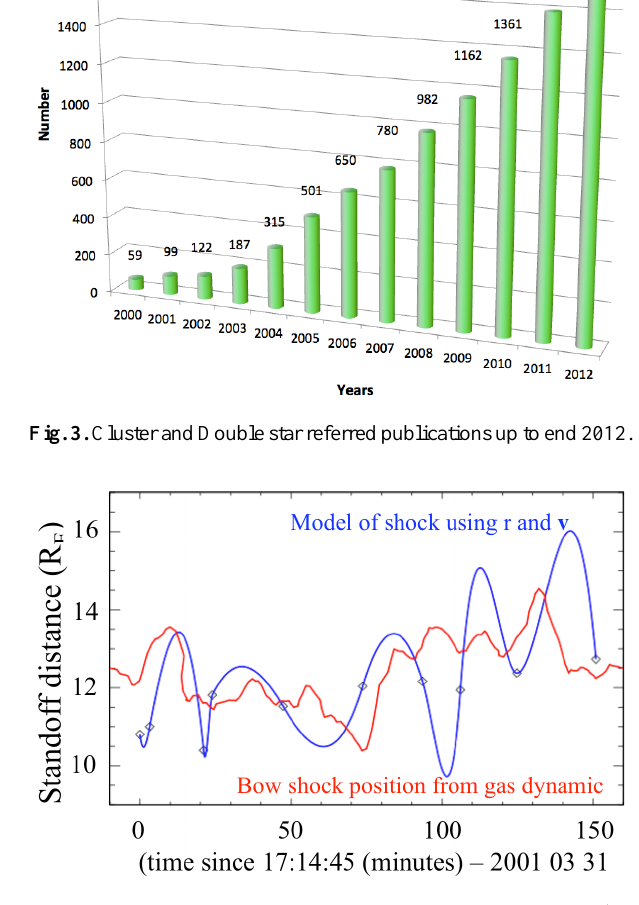
Figure 4. Bow shock distance from Earth as measured by Cluster (diamonds) and possible 3 Fig. 4. Bow shock distance from Earth as measured by Cluster (di- amonds) and possible model using position and speed (blue line). model using position and speed (blue line). The red line is the bow shock position using the 4 The red line is the bow shock position using the solar wind input solar wind input and a gas dynamic model (from Maksimovic et al., 2003). 5 and a gas dynamic model (from Maksimovic et al.,